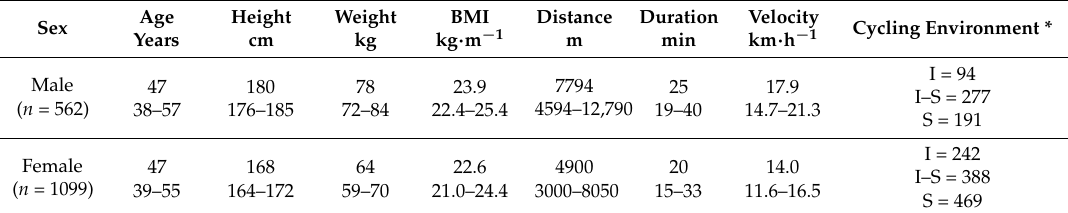
Table 1. Participant characteristics (median and 1st–3rd quartile) ( n =